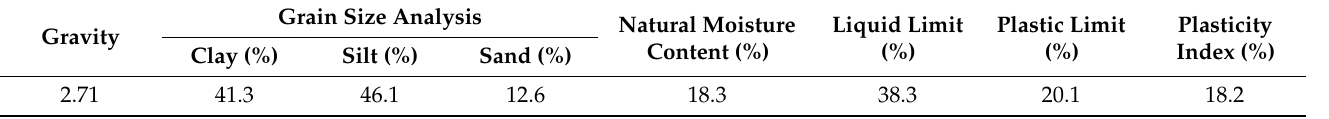
Figure 3. Model test materials and processes: ( a ) undisturbed clay; ( b ) clay that has been sifted after ( f ) custom-made mold; ( g ) curing time; ( h ) clay sample. Table 3. Basic physical properties of